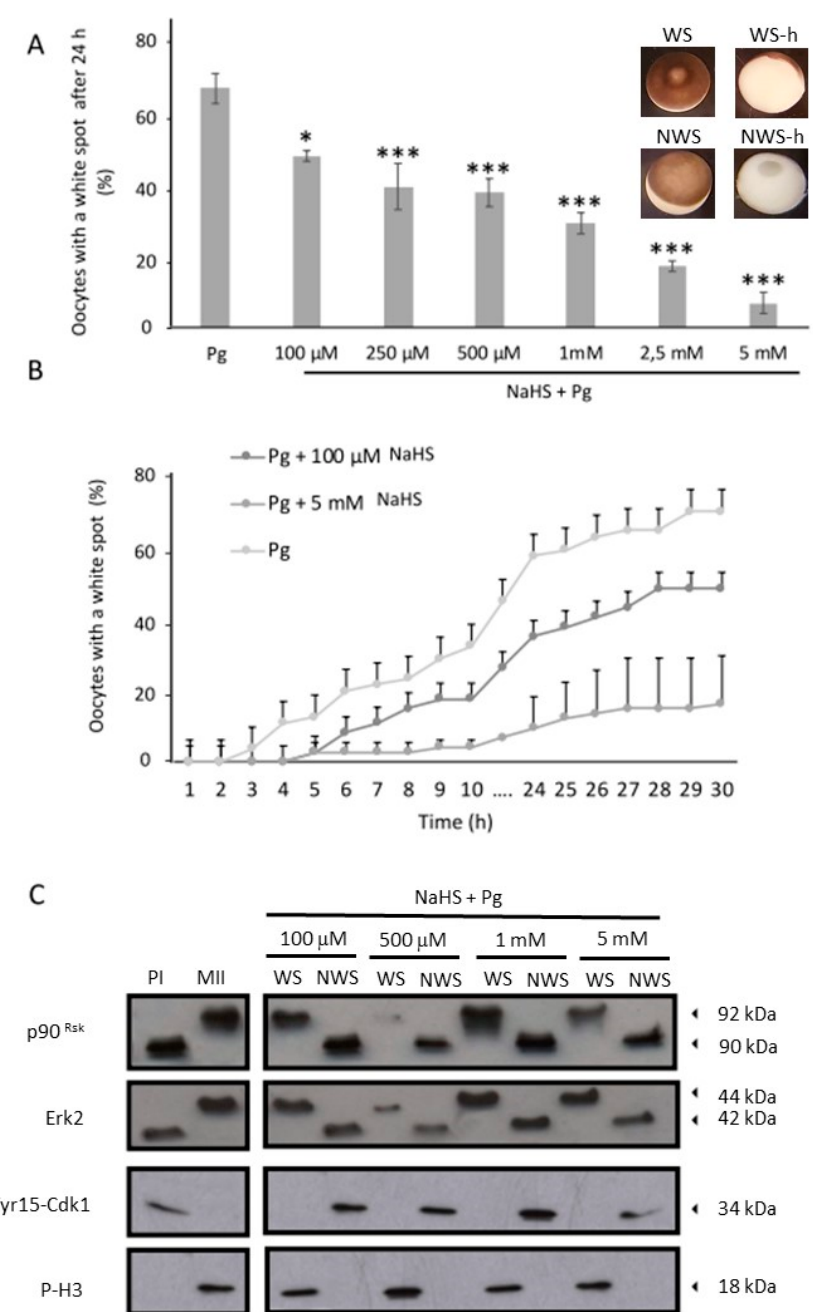
Figure 1. NaHS inhibits meiosis resumption induced by progesterone in a dose-dependent manner. Oocytes were preincubated in NaHS at different concentrations before progesterone addition (4 μ g/mL). ( A ) Percentage of oocytes with a white spot 24 h after addition of progesterone. Statistical significance between control and NaHS conditions was accepted for * p < 0.05 and *** p < 0.001. Microphotographic of whole oocytes with (WS) or without (NWS) white spots and of bisected oocytes along the animal/vegetative axis after heating 15 min at 100 °C (WS-h/NWS-h) are shown. ( B ) Oocytes exhibiting white spots were scored every hour (0–10 h and 24 h–30 h). ( C ) Western blot of p90 Rsk and Erk2 (on modified polyacrylamide gels, the phosphorylated forms have a slower mobility shift), phospho-Tyr15-Cdk1 and phospho-ser10-H3. Some oocytes were maintained in culture medium without treatment (prophase I, PI) or treated by progesterone alone (metaphase II, MII). Oocytes were sorted into two groups: without (NWS) or with a white spot (WS). Experiments were performed on 20 oocytes per condition and three independent females.